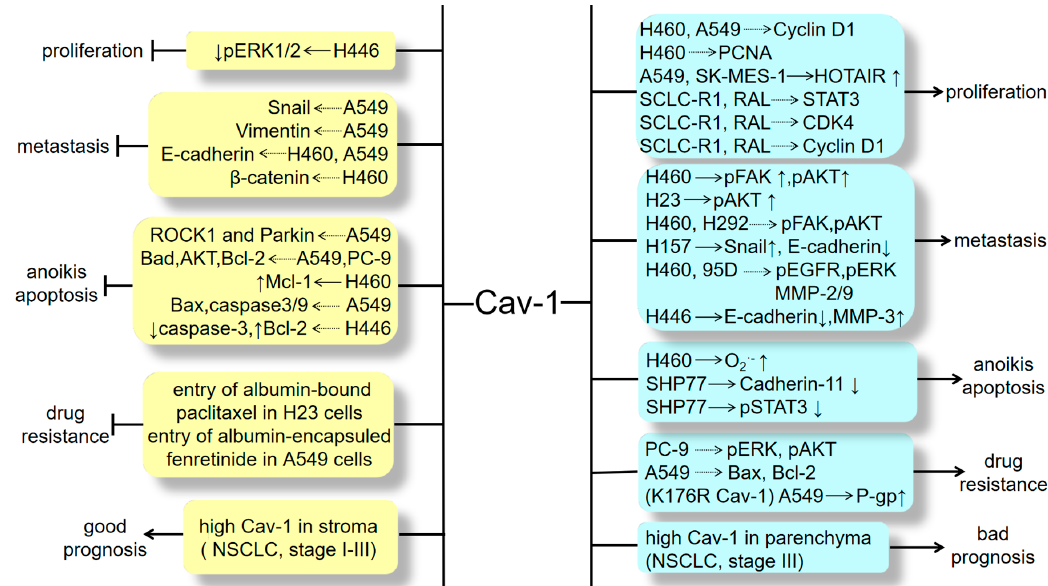
Figure 3. The dual roles of Cav-1 on regulating lung cancer development, including cell proliferation, metastasis, apoptosis, drug resistance and predicting patients’ survival. The dotted arrow indicates the mechanism that hasn't been elucidated clearly.